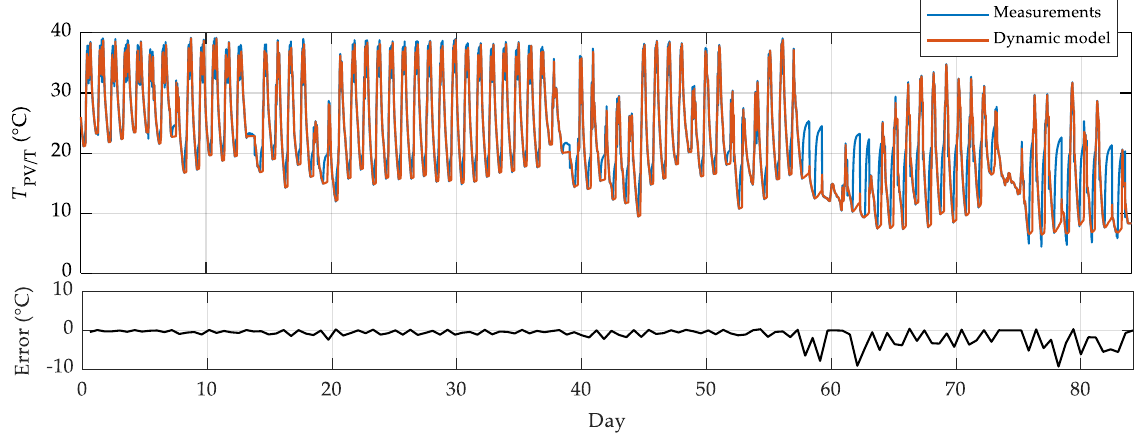
Figure 9. Validation of a dynamic thermal model of a PV/T collector with measurements for 83 days.